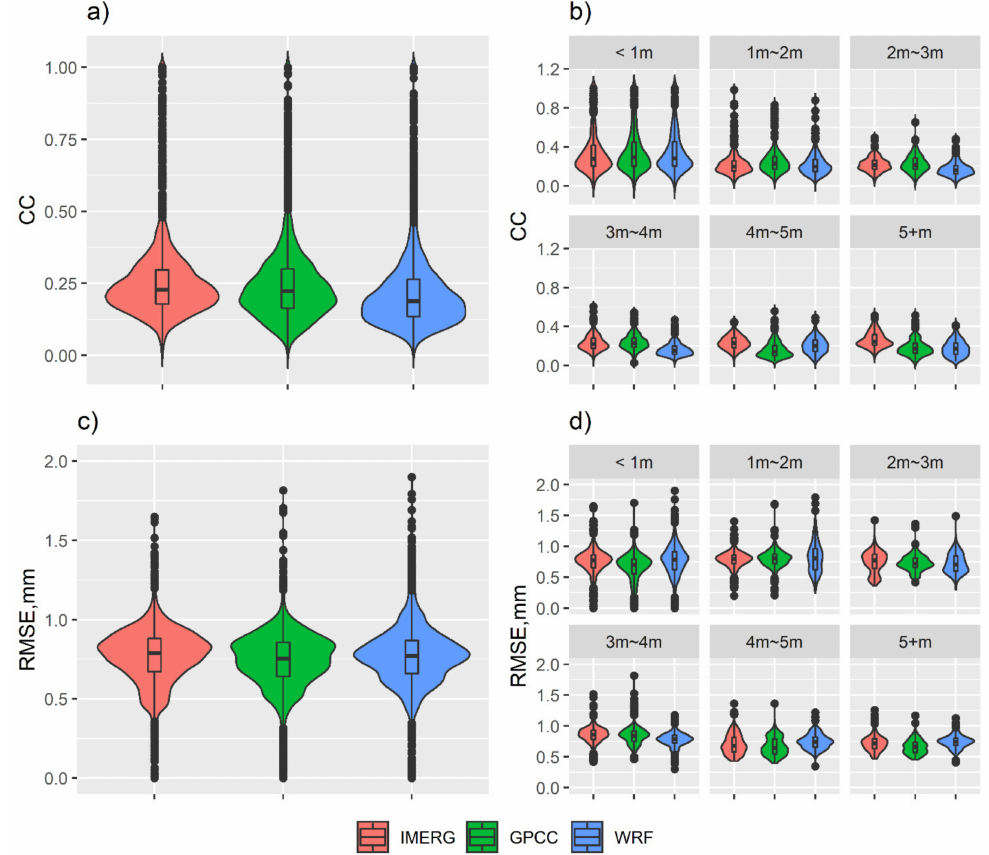
Figure 9. The violin plot of MTC analysis results ( a , c ) for GPM IMERG, GPCC, and WRF simulations from 2010 to 2019 at a monthly scale, and the breakdown results ( b , d ) based on their averaged annual precipitation